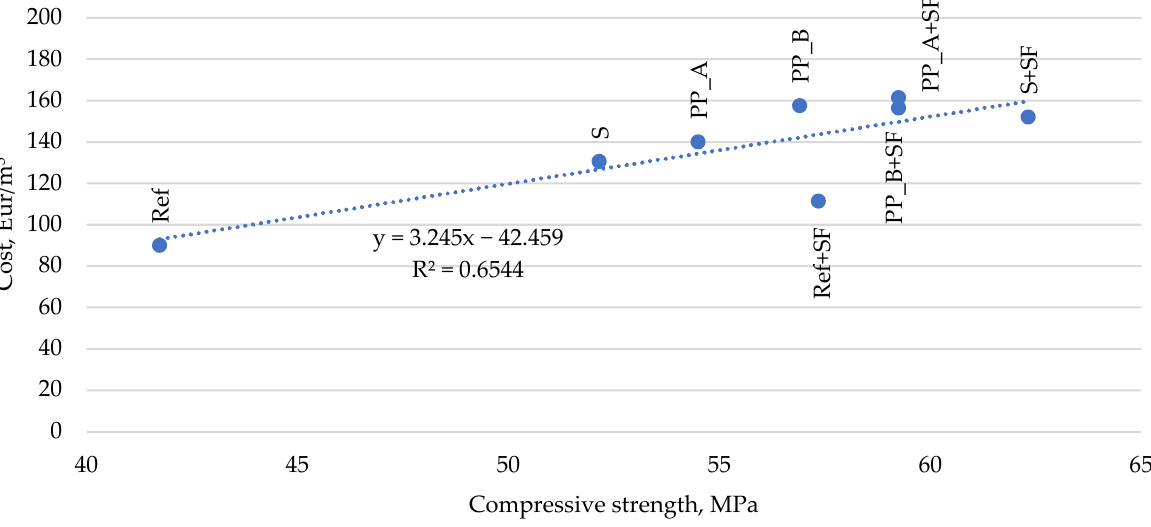
Figure 7. Cost of fresh concrete in terms of compressive strength.